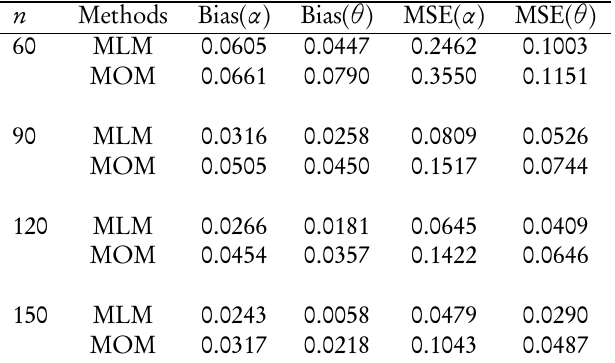
Monte Carlo simulation results for α = 0.3 , θ = 2